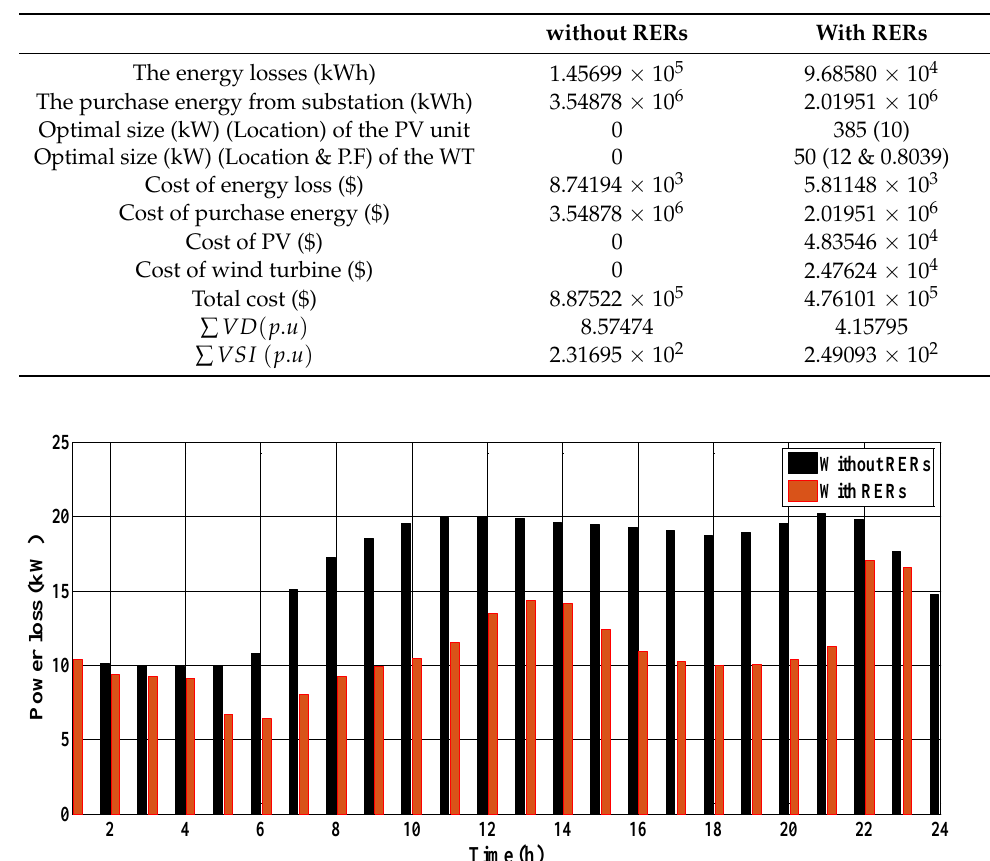
Figure 16. The power losses considering the uncertainties of the system.